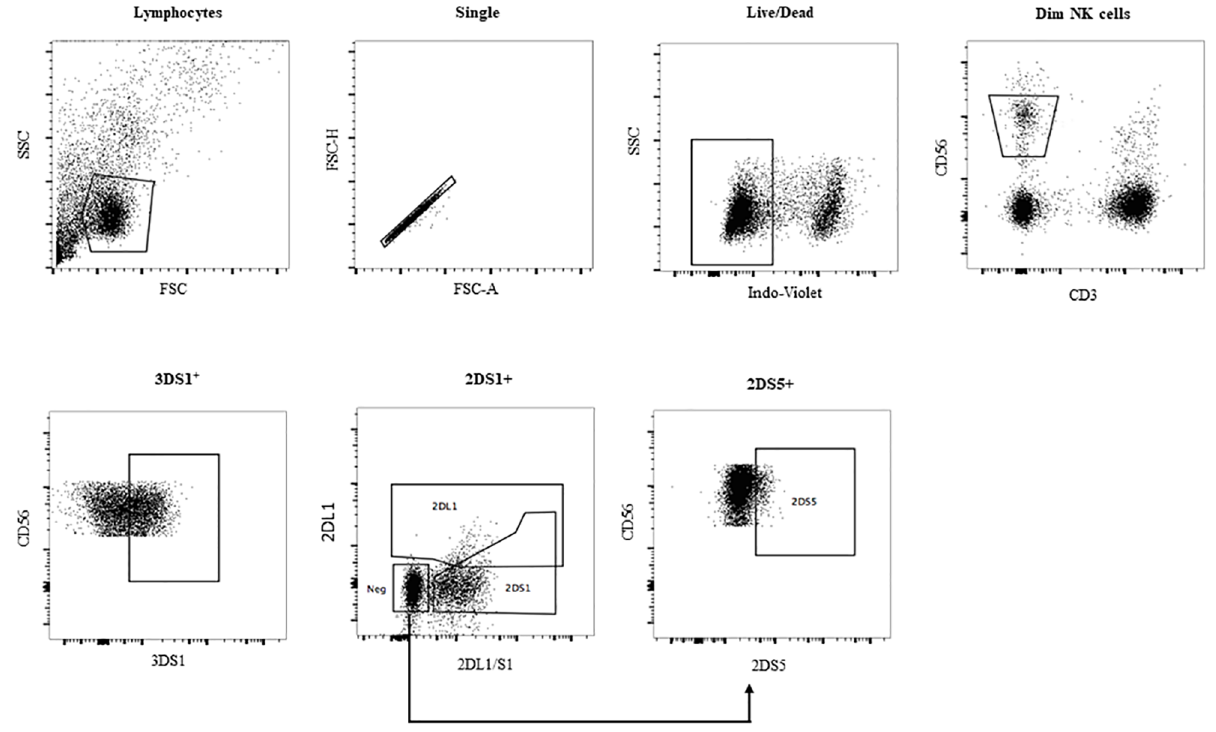
Fig 6. The gating strategy used to determine the frequency of NK cells expressingKIR3DS1, KIR2DS1and KIR2DS5. Live singlet lymphocytes were gated on. From this population,CD3 - CD56 dim NK cells were identified from which the frequency of NK cells expressing KIR3DS1 (3DS1) was assessed. CD3 - CD56 dim NK cells were also gated on to determinethe frequency of cells expressingKIR2DS1 (2DS1). This was accomplishedby using the monoclonal antibody(mAb) REA284 specific for KIR2DL1 (2DL1) only, to bind this KIR making it unavailablefor recognition by a second mAb (11PB6) conjugated to a different fluorochrome that was specific for both 2DL1 and 2DS1. This strategy permitted the separation of 2DL1 + 2DS1 - NK cells from 2DL1 - 2DS1 + cells and 2DL1 - 2DS1 - NK cells [42]. To detect KIR2DS5 + NK cells, the CD3 - CD56 dim 2DL1 - 2DS1 - NK cells from the previous gate that bound to mAb HP-MA4 specific for 2DL1/2DS1/KIR2DS3 (2DS3)/KIR2DS5 (2DS5) were gated on. Since 2DS3 is not cell surface expressed,this mAb detected only 2DS5 + NK cells among those negative for 2DL1 and